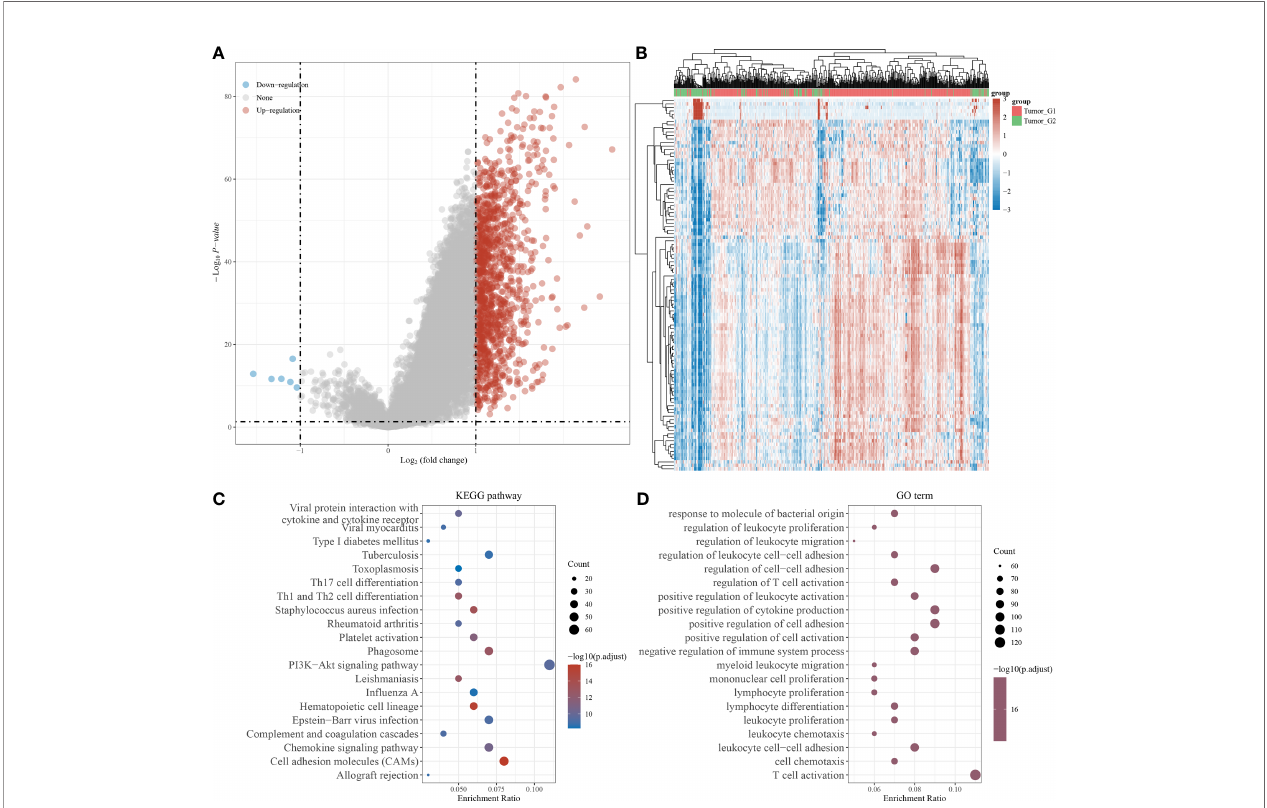
FIGURE 5 | Identi fi cation of differentially expressed genes (DEGs) of IPMs and functional annotations. (A) Volcano plots were constructed using fold-change values and adjusted p based on the high and low risk score of IPMs for predicting PFS of ccRCC patients from TCGA. The red point in the plot represents the overexpressed mRNAs and the blue point indicates the downexpressed mRNAs with statistical signi fi cance. (B) Hierarchical clustering analysis to identify DEGs of IPMs in ccRCC, which were differentially expressed between tumor and normal tissues. (C, D) The enriched KEGG signalingpathways and GO functional enrichment (including biological process, cellular component, and molecular function) analysis were selected to demonstrate the primary biological actions of major DEGs of IPMs based on ClusterPro fi ler package in R